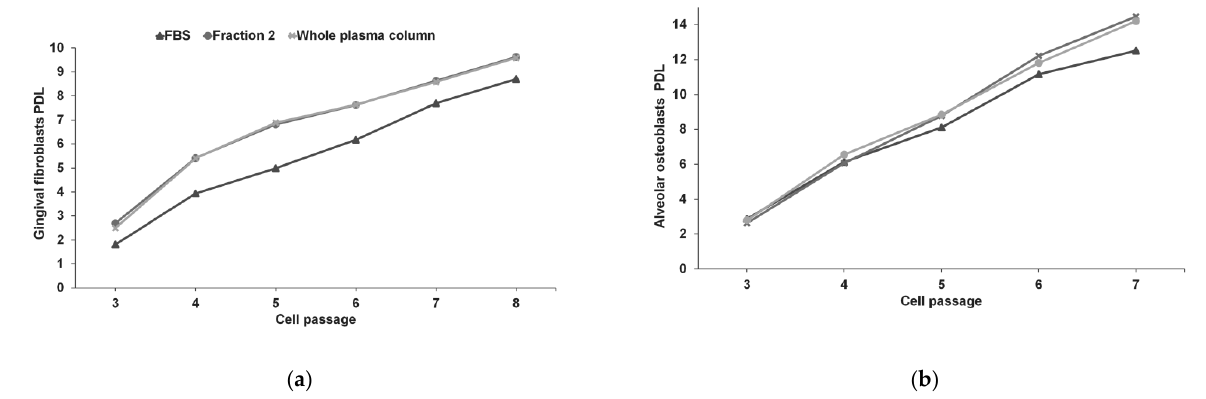
Figure 2. Accumulated PDL throughout the passages after culture with the corresponding supple- ments. ( a ) Gingival fibroblasts; ( b ) Alveolar